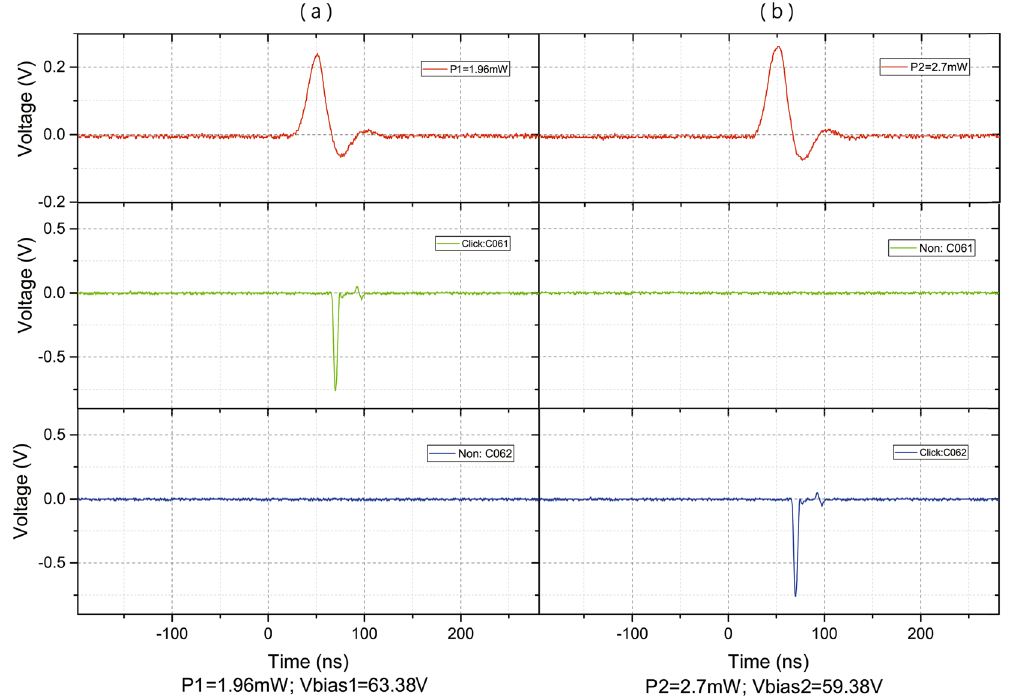
Figure 4. Electrical signal oscillograms when the APDs in SPDs Co62 and C061 are controlled by the trigger pulse peak power with a corresponding biased voltage. ( a ) The values P = 1.96 mW and V bias = 63.38 V cause a detection event in detector C061, however, never cause it in detector C062. ( b ) In contrast, the values P = 2.7 mW and V bias = 59.38 V cause a detection event in detector C062, however, never cause it in detector C061.